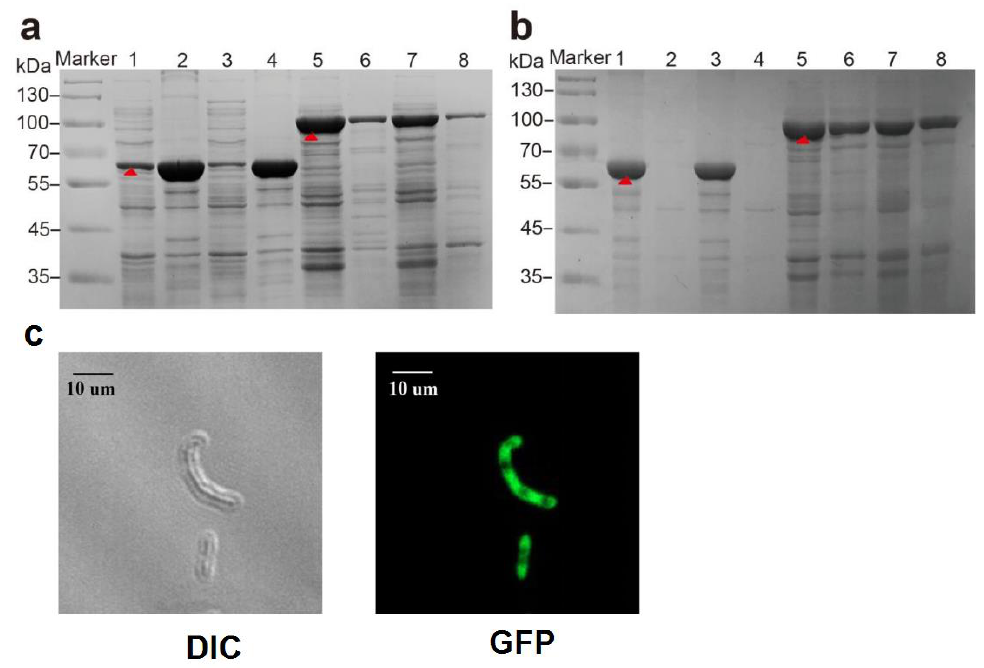
Figure 3. Analysis of PAP-Pb and sfGFP-PAP-Pb. ( a ): SDS-PAGE analysis of the protein expression. Lane 1: supernatant of the cell lysate of PAP-Pb without induction; lane 2: precipitate of PAP-Pb cell lysate without induction; lane 3: supernatant of PAP-Pb cell lysate after induction for 10 h; lane 4: